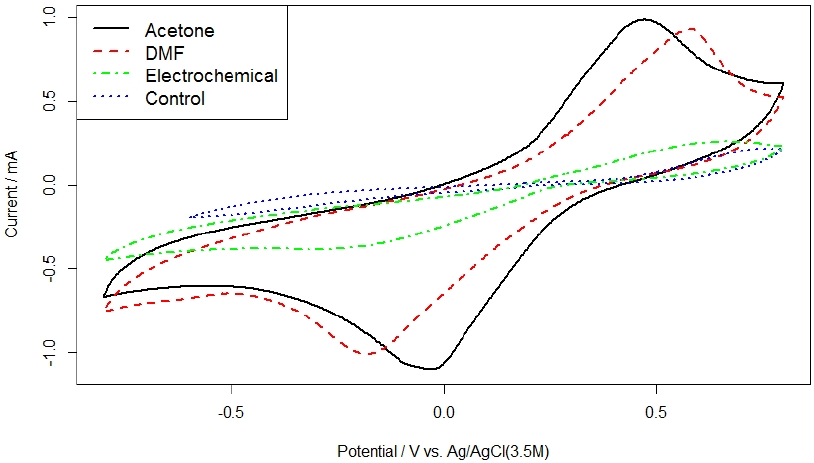
Figure 2. Cyclic voltammograms obtained for the different activation methods using the redox couple Fe(CN) 6 ] 4–/3– at 2 mV · s − 1 .